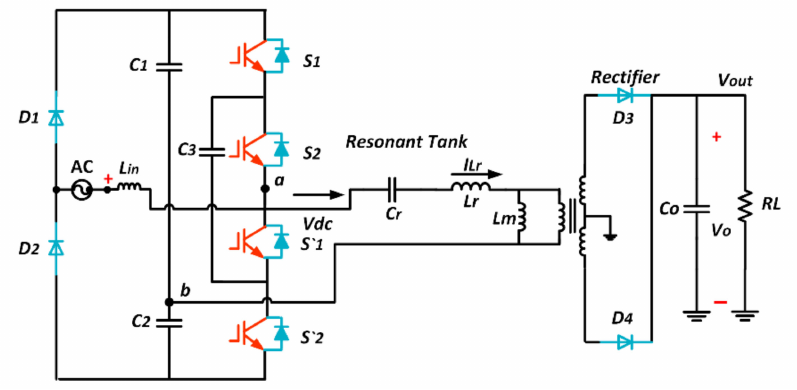
Figure 36. Circuit diagram of three-level single-stage LLC converter